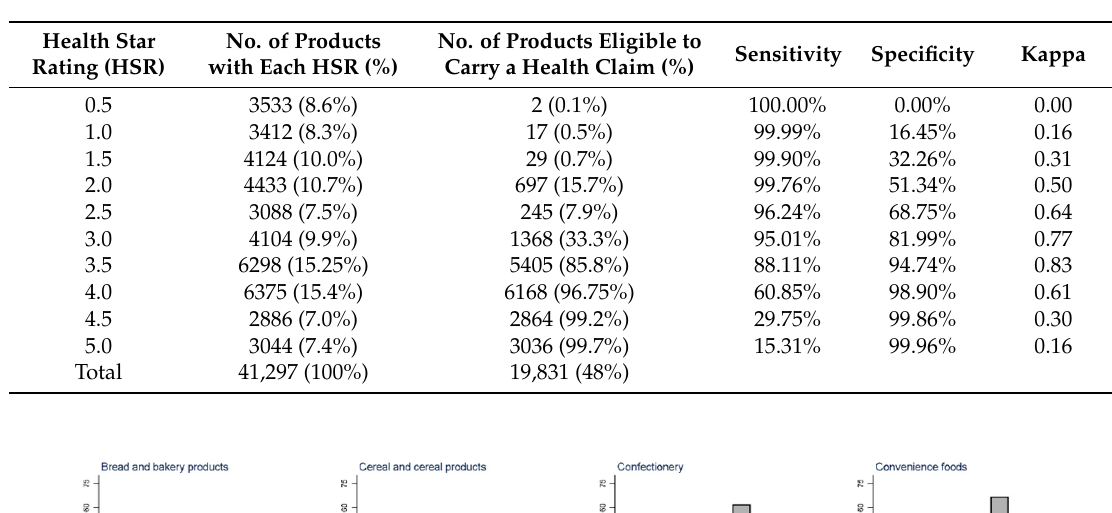
Table 2. Agreement between the Health Star Rating and the eligibility to display a health claim using the Nutrient Profiling Scoring Criterion.